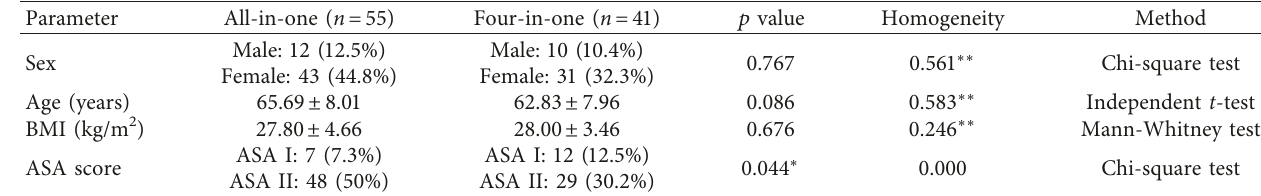
Table 1: Demographics of the patients.